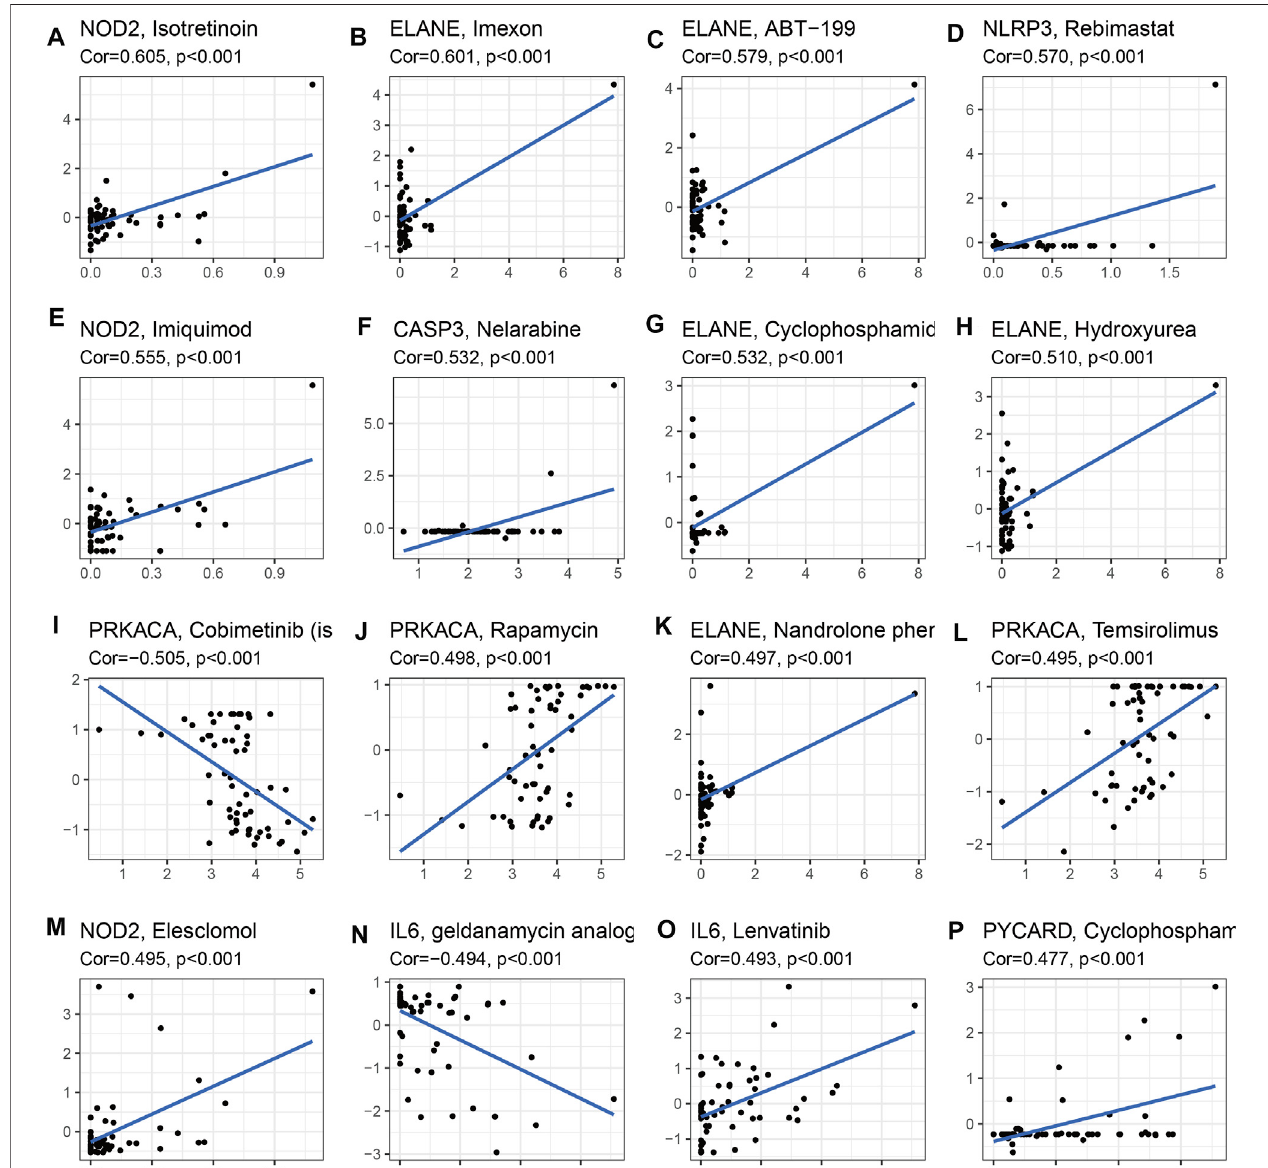
FIGURE 9 | Drug sensitivity analysis for identi fi ed prognostic-related genes based on TCGA dataset (Top 16). (A) NOD2 and isotretinoin. (B) ELANE and Imexon. (C) ELANE and ABT-199. (D) NLRP3 and Rebimastat. (E) NOD2 and Imuiquimod. (F) CASP3 and Nelarabine. (G) ELANE and Cyclophosphamid. (H) ELANE and Hydroxyurea. (I) PRKACA and Cobimetinib. (J) PRKACA and Rapamycin. (K) ELANE and Nandrolone. (L) PRKACA and Temsirolimus. (M) NOD2 and Eleschomol. (N) IL6 and geldanamycin. (O) IL6 and Lenvatinib. (P) PYCARD and